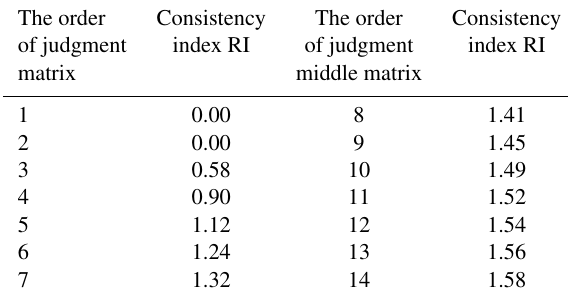
Table 4. Different order values of